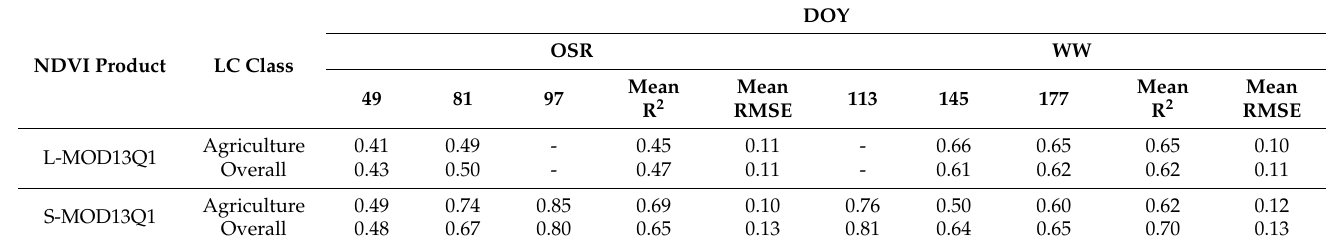
Table 2. Statistical analysis between the NDVI values obtained from raw Landsat (L) and Sentinel-2 (S) images with synthetic images (L- and S-MOD13Q1) on different days of the year (DOY). The analysis shows the R 2 and mean RMSE obtained between the synthetic and reference NDVI in Bavaria for the land cover class of agriculture (which covers 31.67% of Bavaria) and for the overall classes (including agriculture, forest, urban, water, natural, semi-natural, and grassland) in